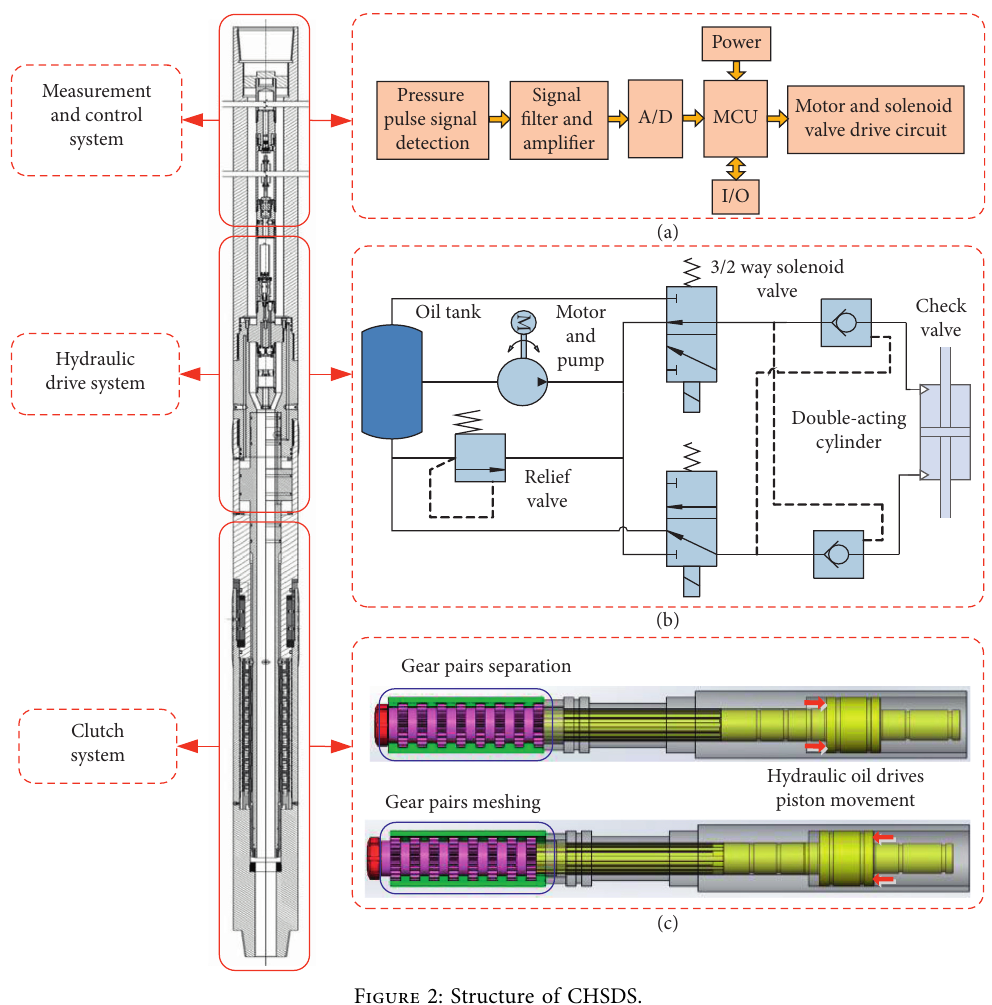
Figure 2: Structure of CHSDS.